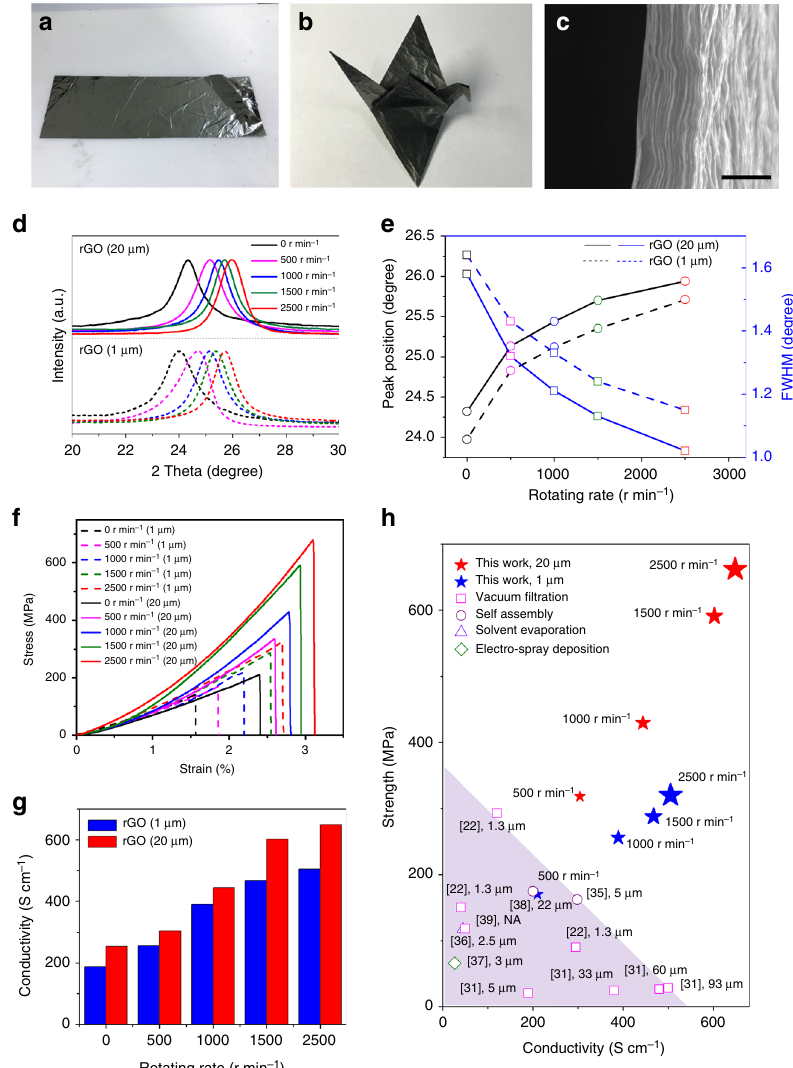
Fig. 3 Structure, electrical and mechanical properties of rGO fi lms. a A large rGO fi lm with a size of 30 × 10 cm 2 . b A origami crane made by rGO fi lm, showing very good fl exibility. c Cross-sectional SEM image of a rGO fi lm. Scale bar: 1 μ m. d – g XRD patterns ( d ), the corresponding XRD peak position and FWHM ( e ), stress-strain curves ( f ) and electrical conductivities ( g ) of the rGO fi lms prepared at different rotating rate using GO nanosheets with different lateral size (~1 μ m and ~20 μ m). h Electrical conductivity and tensile strength comparison of the rGO fi lms prepared by CCC method and other methods 22,31,35 – 39 . The size of the GO nanosheets used is shown for each